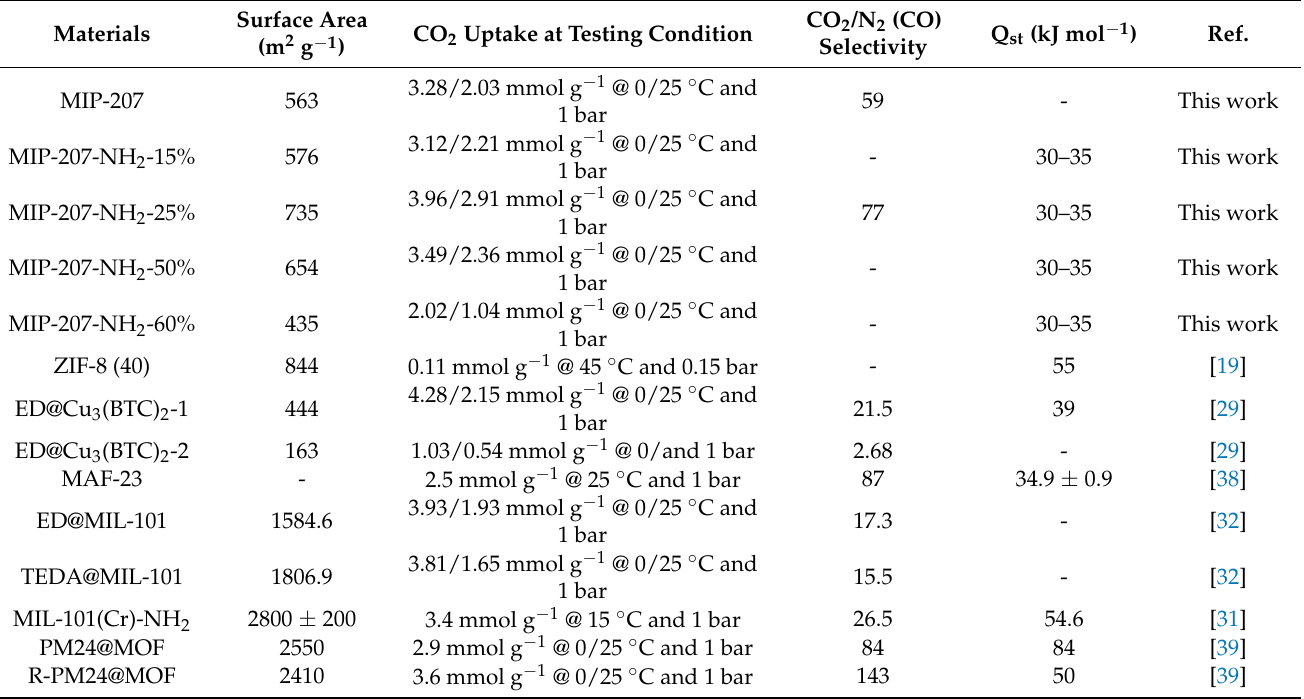
Table 3. The summary of BET area and CO 2 adsorption results in this work and reported amine-functionalized